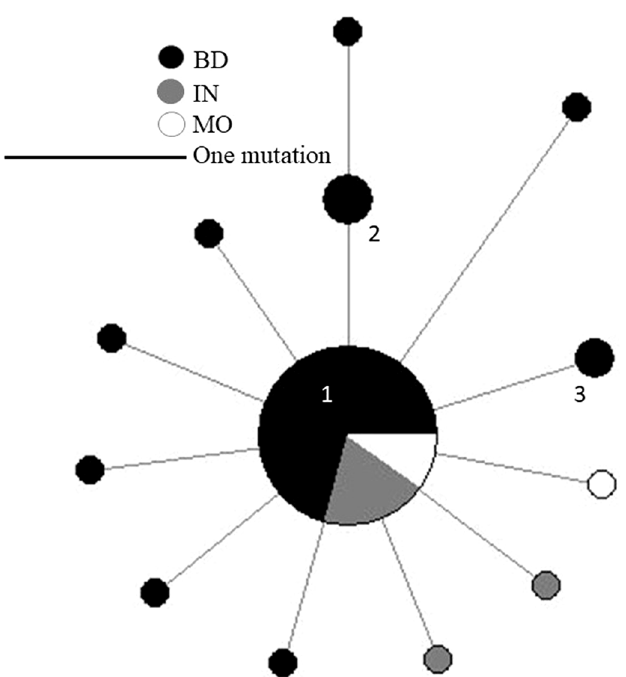
Fig. 2. Median-joining haplotype network based on 56 sequences of mitochondrial CO1 barcode of Parapenaeopsis sculptilis sampled from Bangladesh, India and Mozambique. Each pie is a haplotype and its size presents the frequency of samples. Distances between pies represents to mutational differences between the haplotypes. Shadings denote different sampling locations (BD- Bangladesh, IN- India and MO- Mozambique).